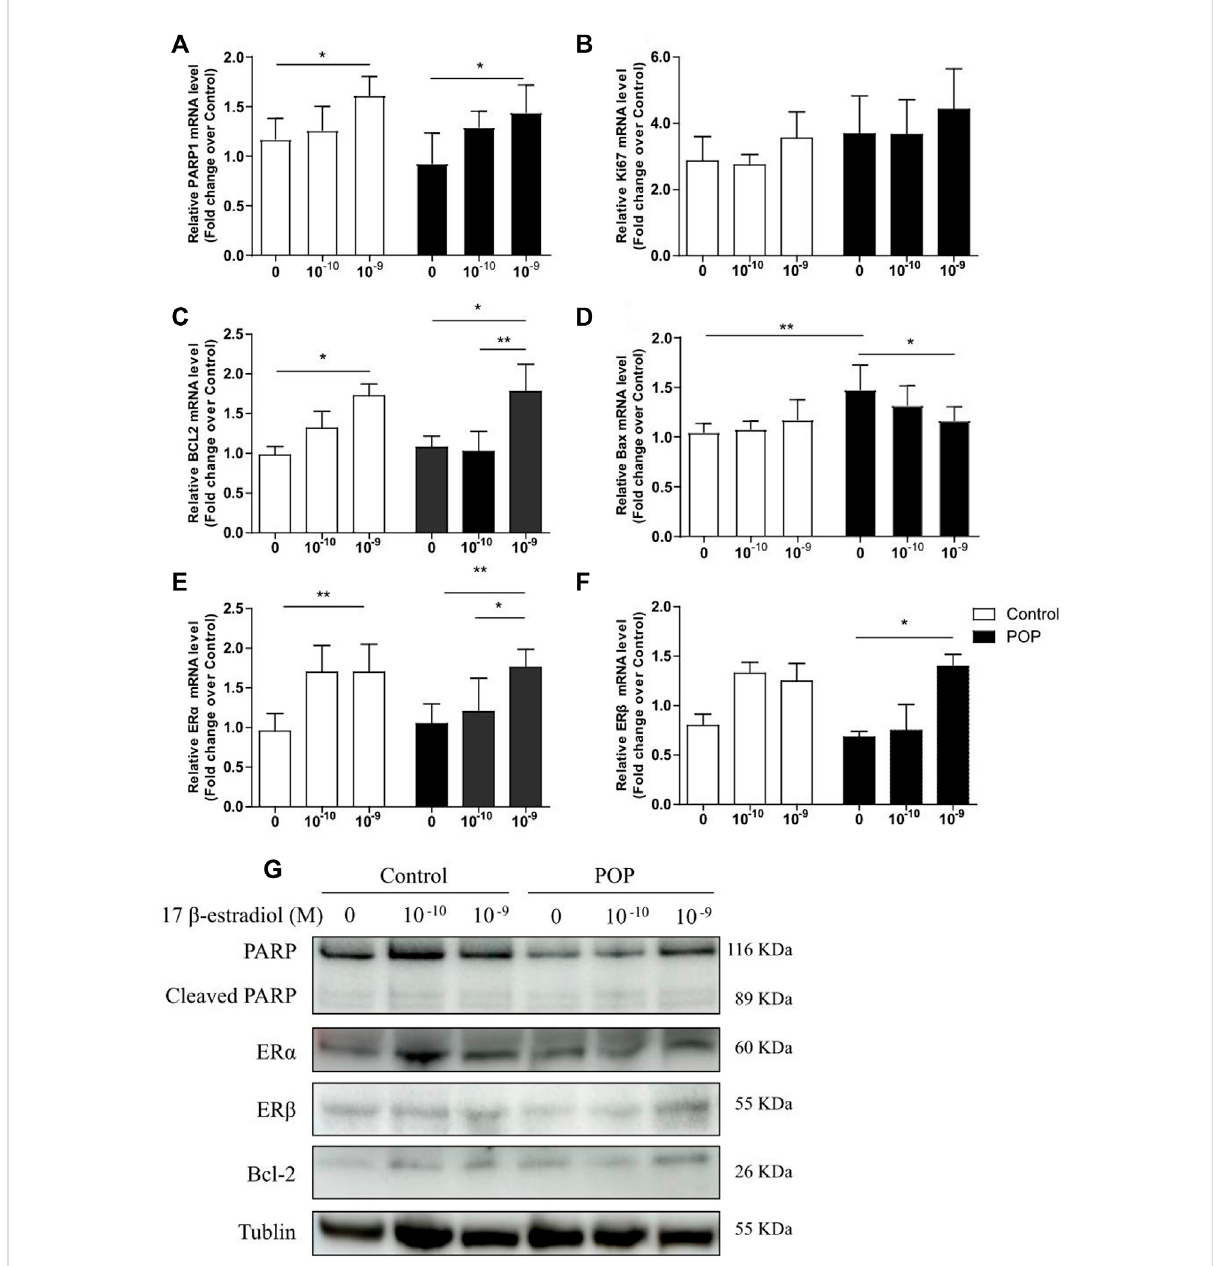
FIGURE 5 Estrogenregulatesapoptosis-relatedproteinsexpressioninhUSLFs.mRNAexpressionlevelsofapoptosis-related genesincludingPARP1,Ki67, BCL2, Bax, ER α , and ER β in hUSLFs (A – F) . Protein expression of PARP1, Cleaved-PARP1, ER α , ER β , BCL2 and Tublin in hUSLFs (G) . Values are expressed as the mean ± standard deviation of three independent experiments. * p < 0.05; ** p <